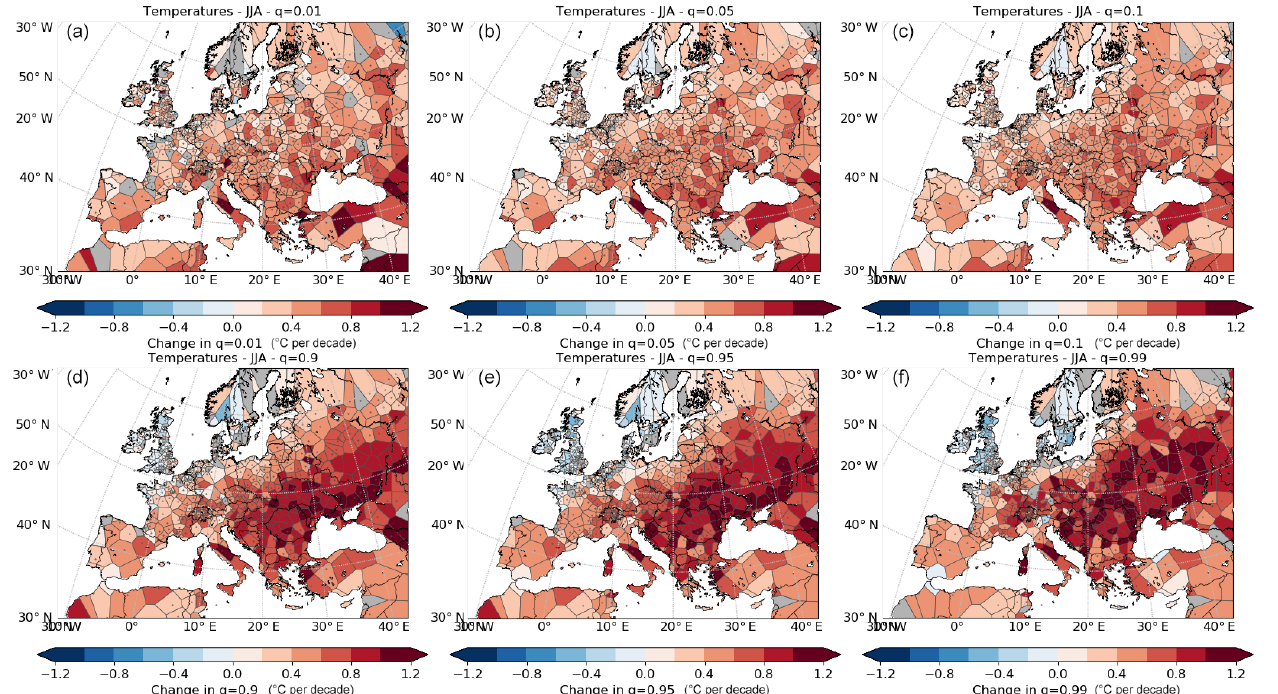
Figure 10. Trend over 1973–2017 in quantiles of temperature ( ◦ C per decade) at (a) 0.01, (b) 0.05, (c) 0.10, (d) 0.90, (e) 0.95 and (f) 0.99 over Europe during summer (JJA).